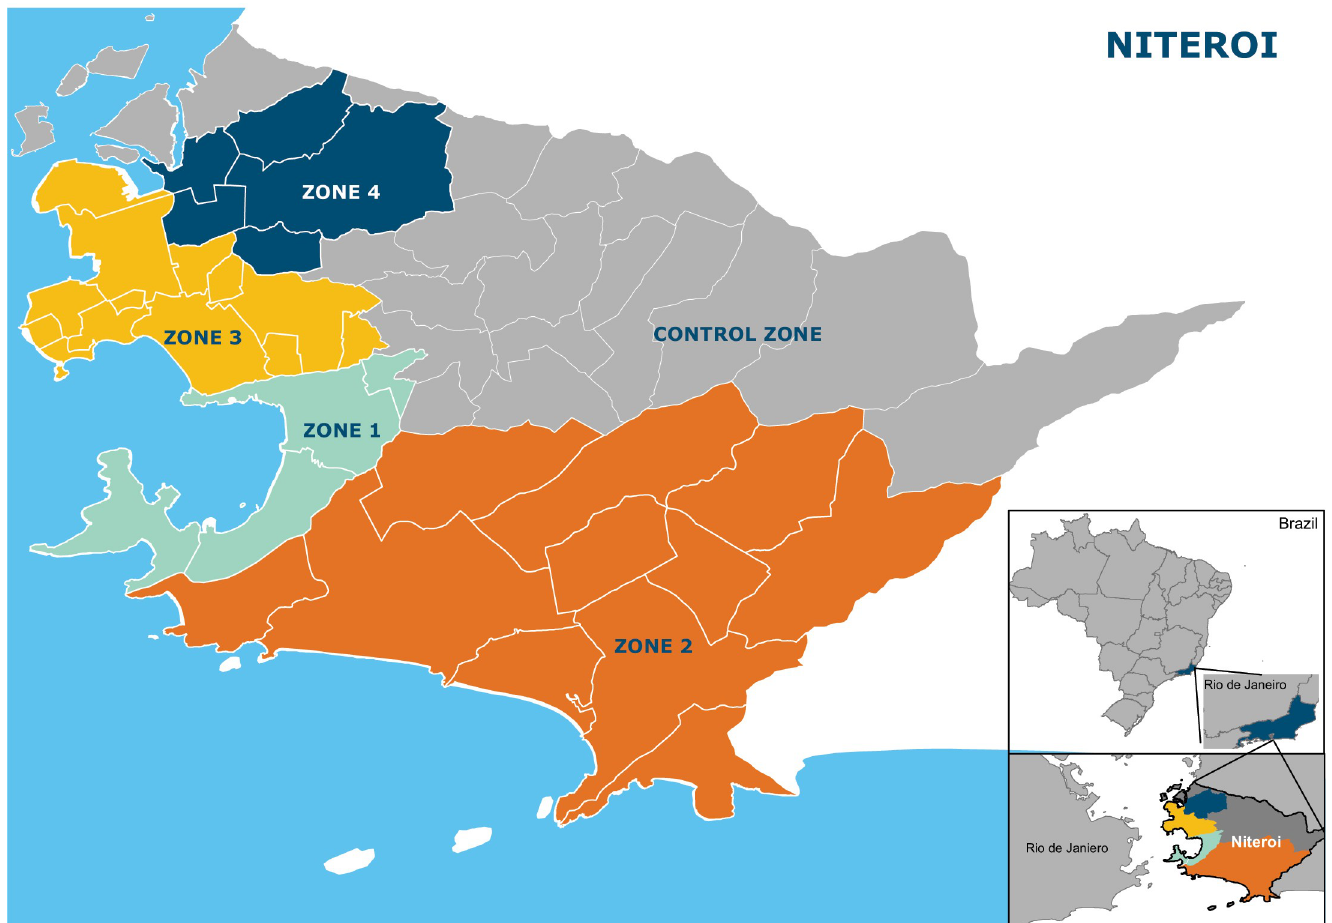
Fig 1. Study site map showing the municipality of Nitero´i, comprising four zones in which releases of w Mel-infected Aedes aegypti have been undertaken and one pre-defined parallel untreated control zone. Neighbourhood boundaries are shown in white. The inset shows the location of Nitero´i within the state of Rio de Janeiro, Brazil. Maps were generated in ArcGIS 10.7 (Esri, Redlands, CA, USA) using administrative boundaries freely available from the Brazilian Institute of Geography and Statistics (IBGE).